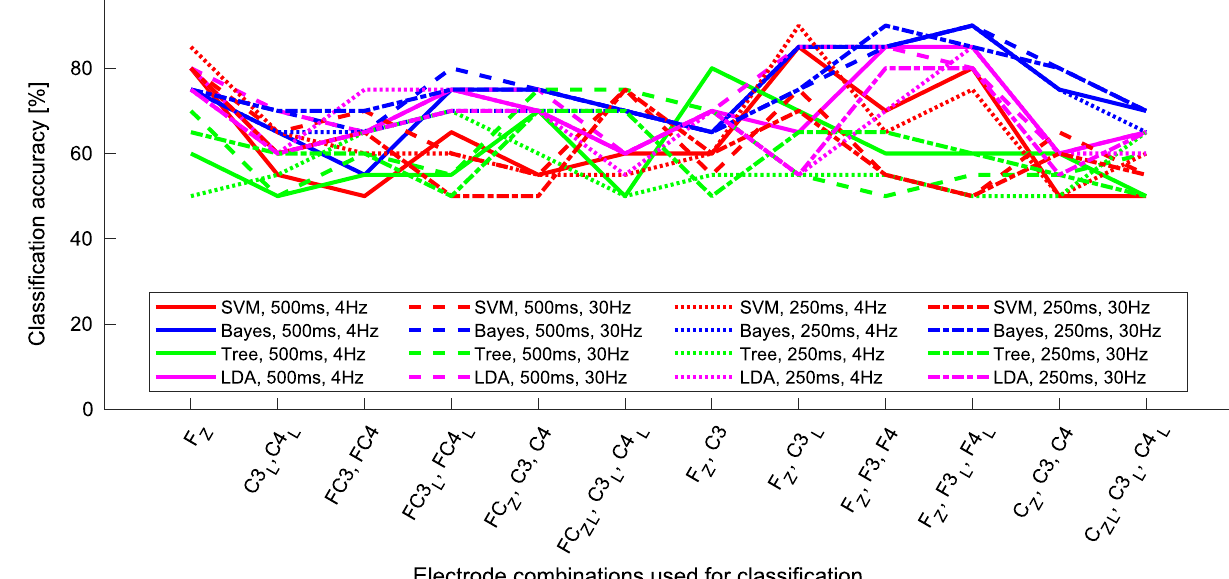
Figure 3. Classification results of the validation set when different parameters for feature extraction and classification were used when using the Laplacian mask. Shown are results when the upper frequency of the band-pass filter was 4 Hz or 20 Hz, the length of interval was 250 ms or 500 ms, the classifier used was either SVM RBF , Bayes, Decision Tree or LDA, for different combinations of CSP components. On x-axes are plotted combinations of channels for positioning Laplacian mask, where L in subscript indicates large Laplacian mask. For better visibility results for only selected values for upper band frequency and interval length are presented. Results obtained with SVM classifier with polynomial kernel and QDA classifier are also omitted, since the results were similar to those obtained using the SVM RBF and LDA, respectively, although generally lower. Figure was created using Matlab 2020b (https:// www. mathw orks. com/ produ cts/ matlab.